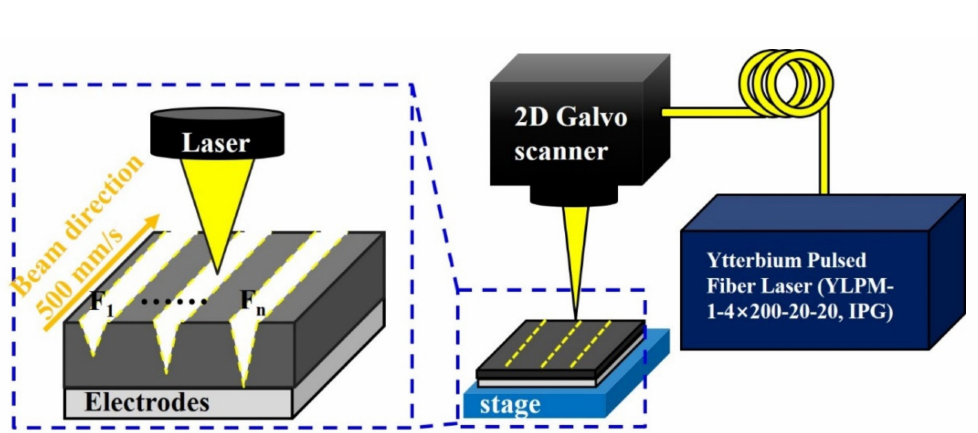
Figure 2. A laser processing system for the structuring of 3D